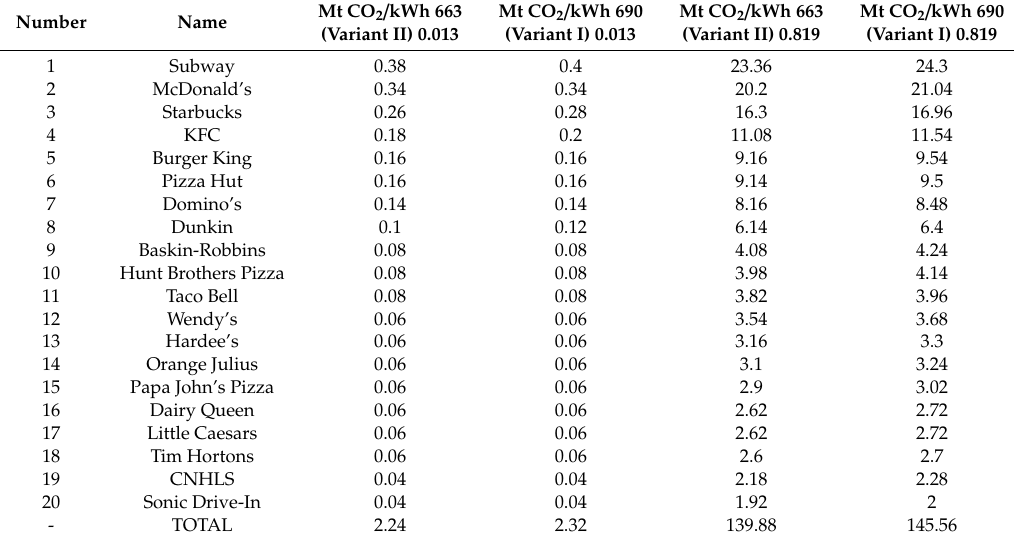
Table 12. Estimations of daily emission of carbon dioxide for world-wide distributed restaurants of particular